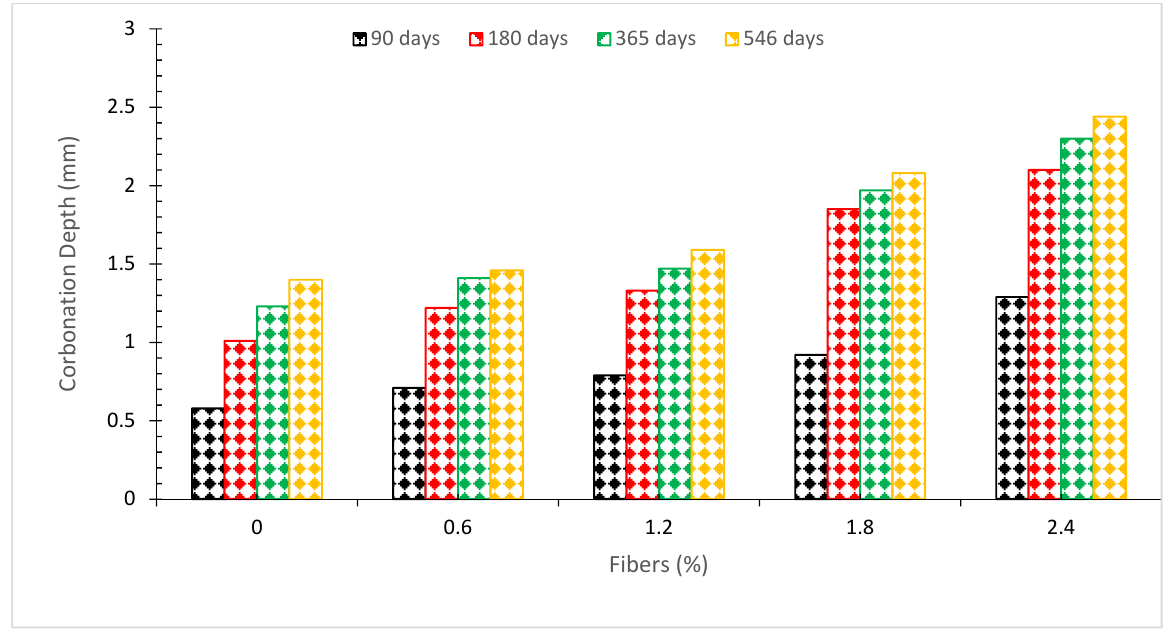
Figure 14. Carbonation depth [37].